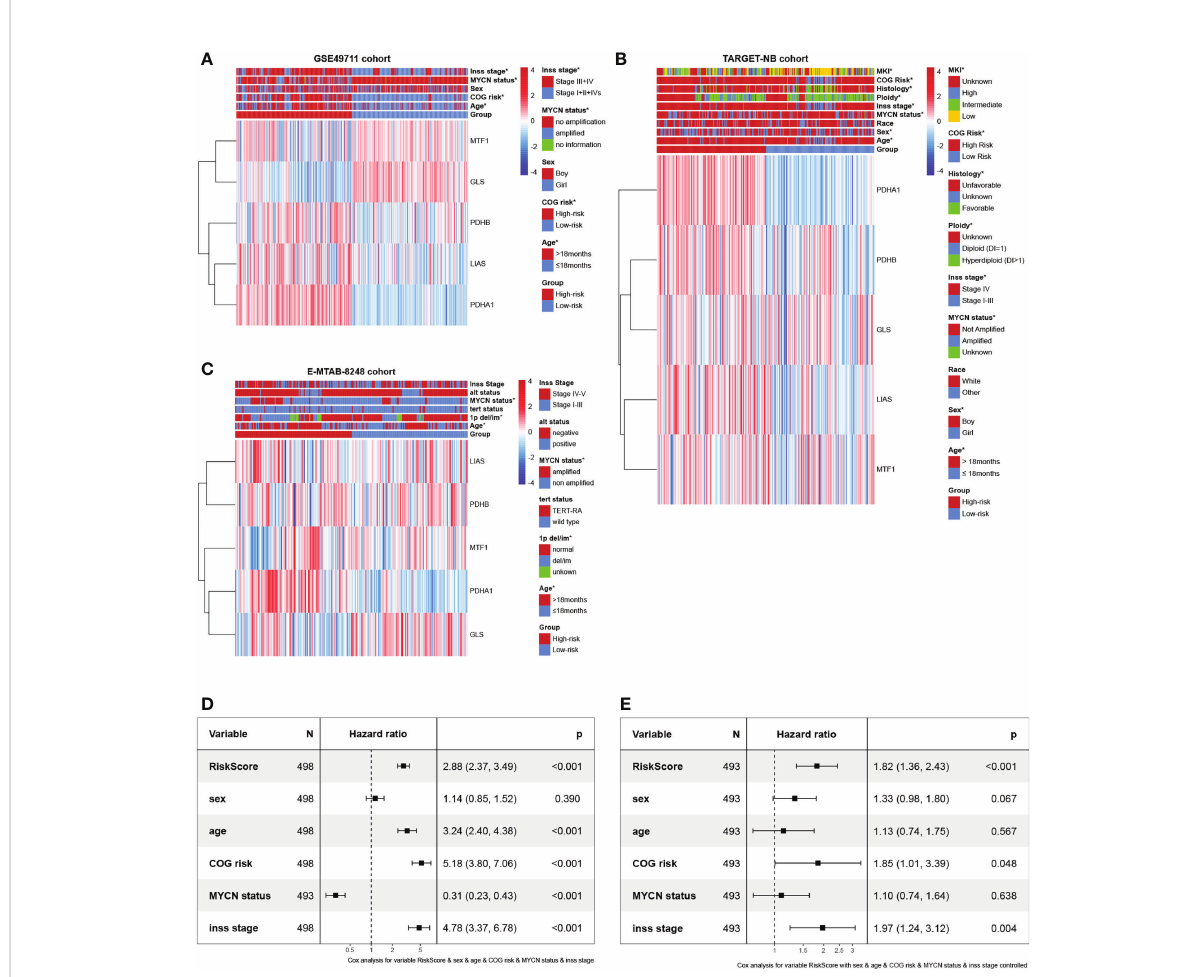
FIGURE 5 Prognostic value and clinical relevance of the cuproptosis-related gene signature. (A – C) Relationships between clinicopathologic features and the two risk subgroups in the GSE49711, TARGET-NB, and E-MTAB-8248 cohort. (D, E) The univariate and multivariate Cox regression analysis of risk factors in NB in the GSE49711